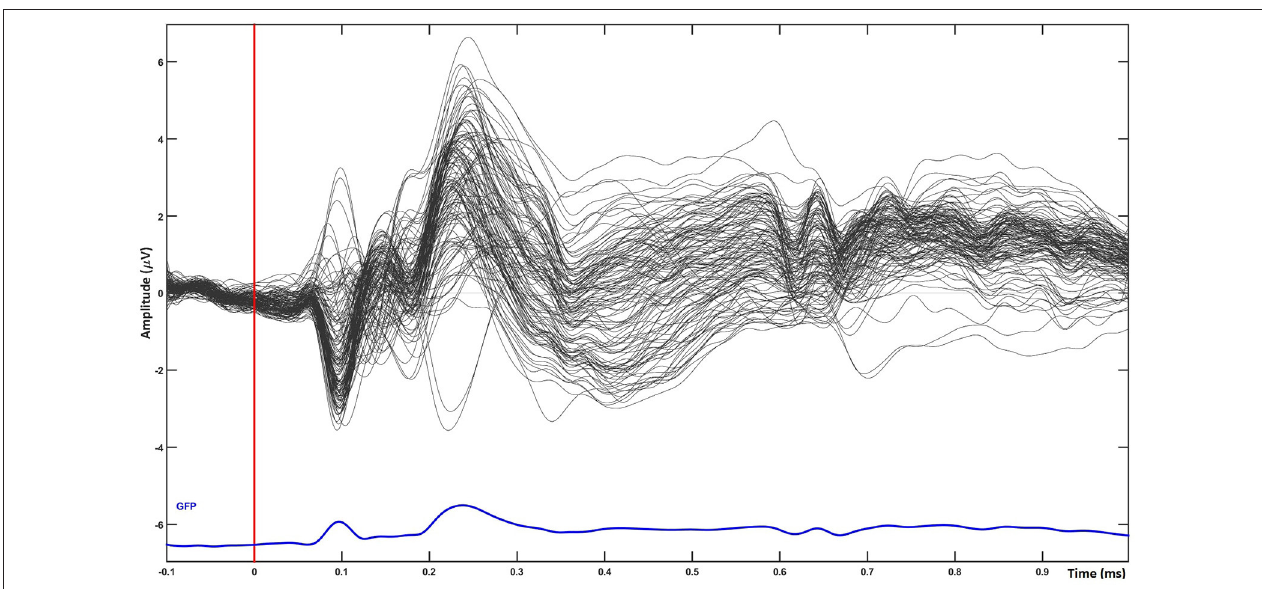
FIGURE 3 | temporal plot for single word processing averaged over all groups of words (grand average of all trials). The plot shows the quality of ERP data used for source analysis.